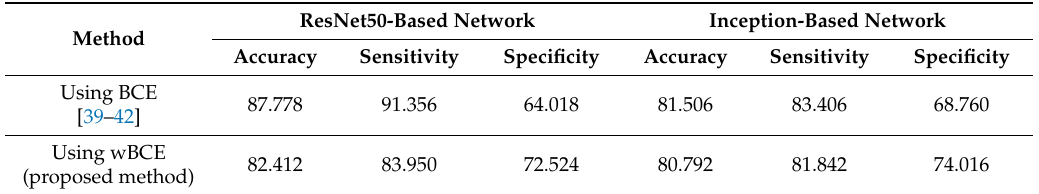
Table 6. Classification performance of the individual CNN network using the TDID dataset (unit: